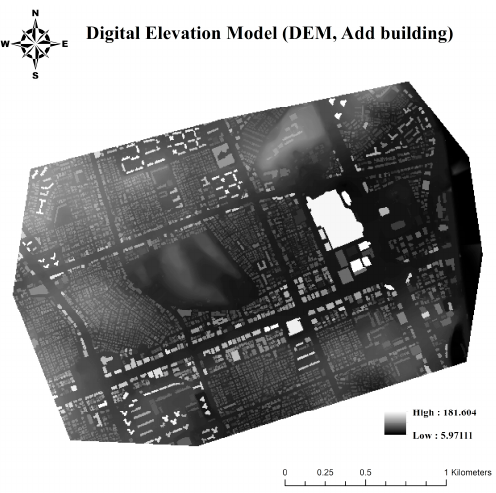
Figure 5. Digital elevation model (DEM) for the target area. In addition, the exact location of each manhole was found by using the spatial join tool in the ArcGIS model in the whole 5-m cell size digital elevation model simulated domain, which was needed to complete the construction of two-dimensional grids (Figure 6). After completing the two-dimensional grids, the total overflows of each manhole data and the exact location of each manhole were used as the input data for the FLO-2D model. Flood routing and two-dimensional inundation analysis were performed by interactive flood routing between channel, street, and floodplain flow to properly reflect the influence of buildings, and describe the complex floodplain topography. Also, the mapper pro. 2009 tool in the FLO-2D model was used to generate maximum flow depth in the cell map and to generate the optimal inundation map. The optimal inundation maps were generated according to the total overflows, reflecting different temporal rainfall distribution characteristics.